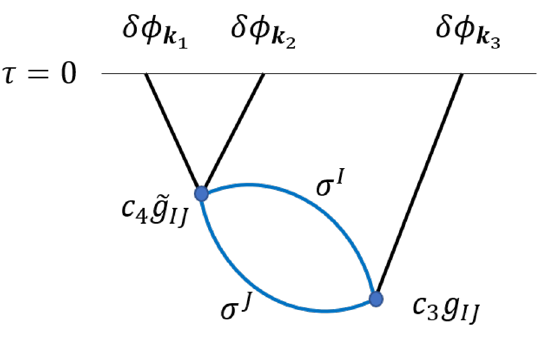
Figure 1 . Contribution of isocurvatons σ I to the